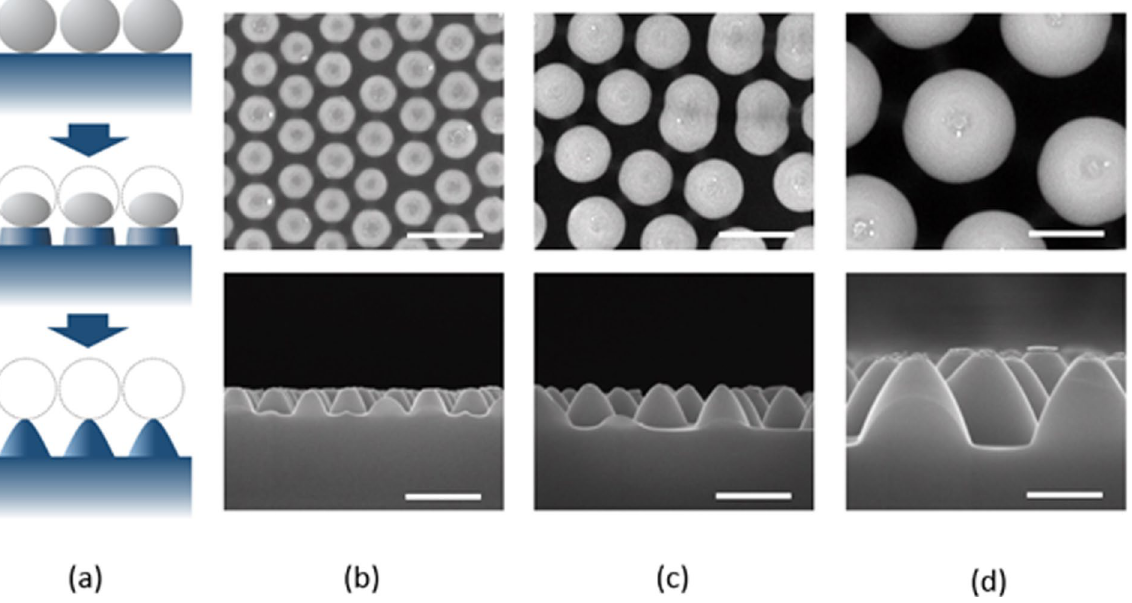
Figure 3. ( a ) Schematic of Si nanostructure fabrication processes with silica beads and a CF 4 /O 2 RIE process. SEM images of the Si nanostructures after an RIE process with different sizes of the silica beads as a mask: ( b ) P360, ( c ) P520, ( d ) P960. The scale bar is 500 nm for all the SEM images.